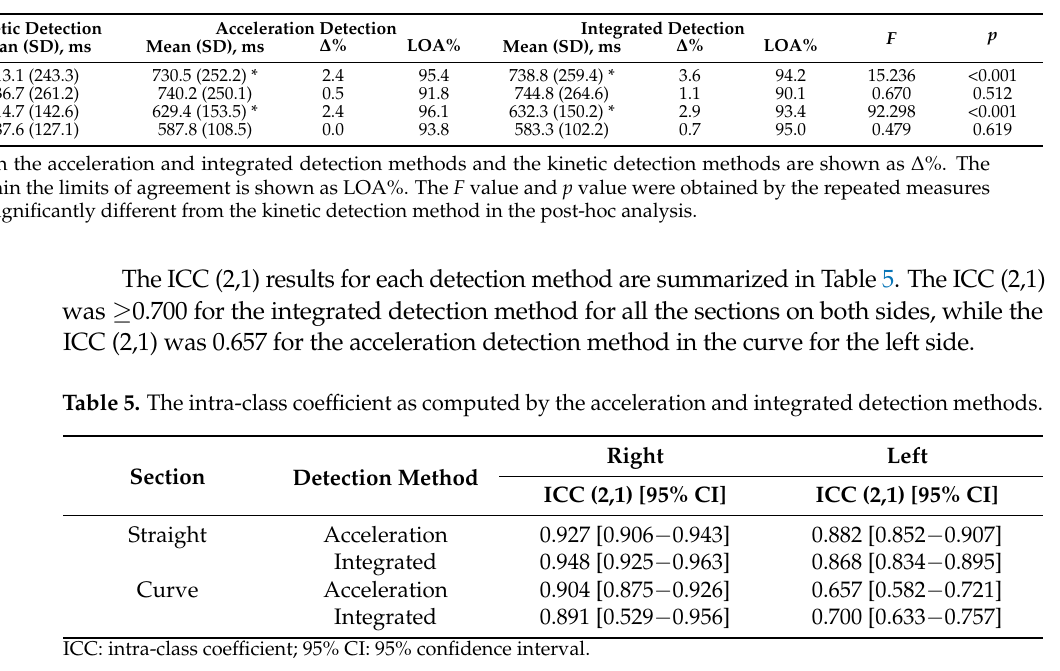
Table 4. Stance time detected by kinetic, acceleration and integrated detection methods.